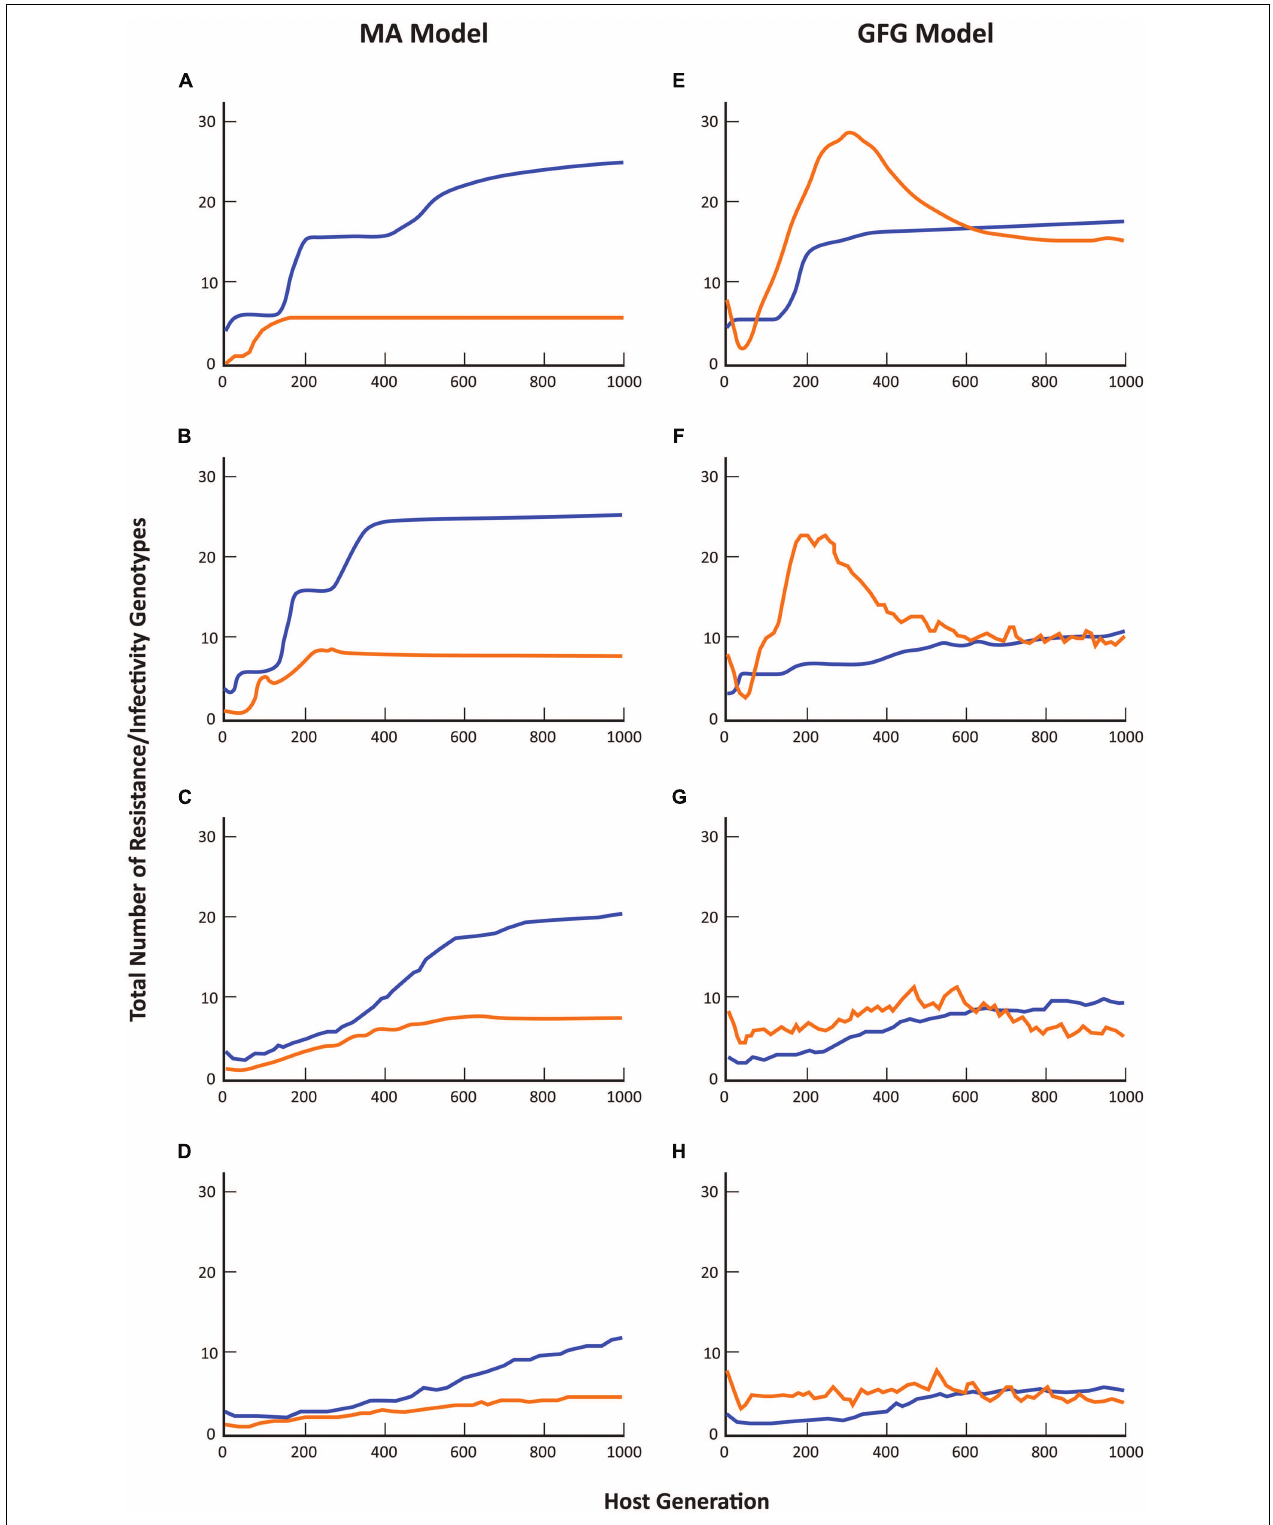
FIGURE 2 | Comparison of coevolutionary patterns predicted by the matching allele and gene-for-gene models. Blue lines represent the total number of host resistance genotypes present across the metapopulation, while orange lines represent the total number of pathogen infectivity genotypes present. Simulation protocols are otherwise as described in Figure 1 and in Thrall and Burdon